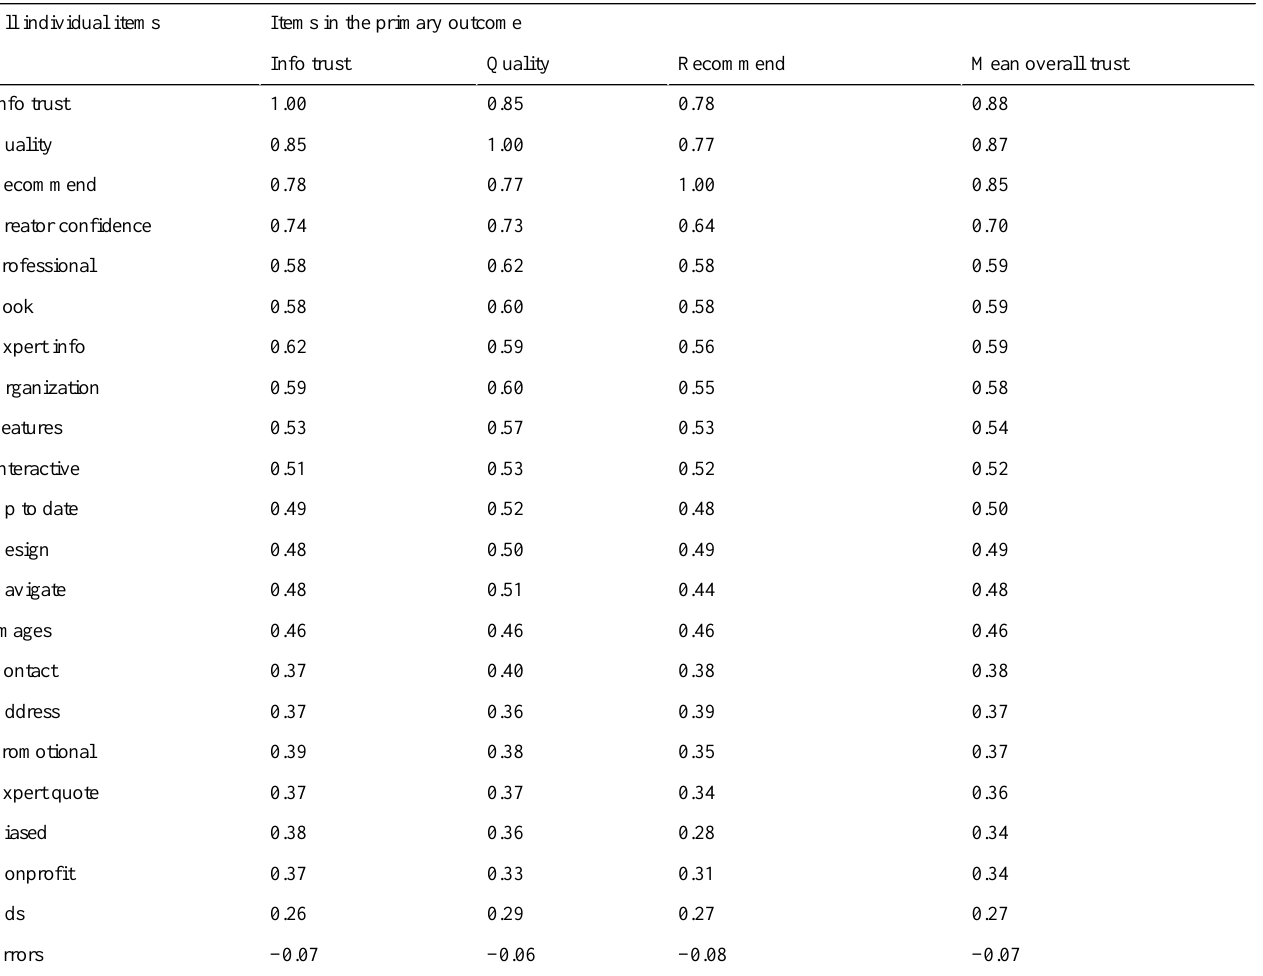
Table 5. Correlation coefficients between items in the primary outcome of mean overall trust and all individual items for all websites except Louisiana. Items in the primary outcomeAll individual